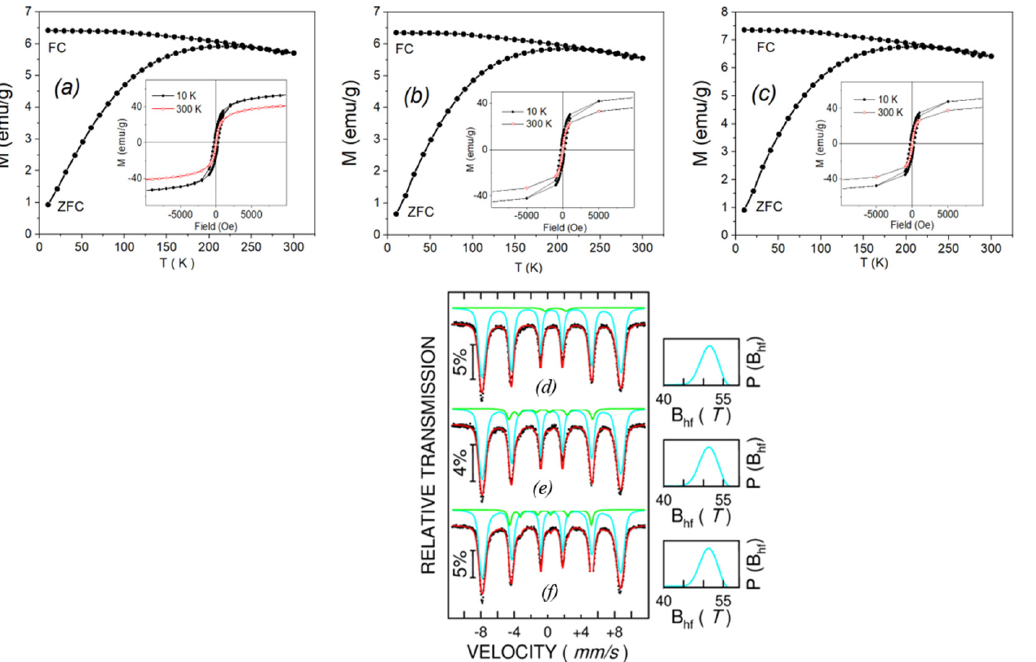
Figure 4. ZFC-FC curves in 100 Oe and hysteresis loops at 10 K (black line) and 300 K (red dashed line) for ( a ) Fe 3 O 4, ( b ) Fe 3 O 4 -L-Cys and ( c ) Fe 3 O 4 -L-Cys-Dox NPs. 57 Fe M ӧ ssbauer spectra collected at 6 K on ( d ) Fe 3 O 4 , ( e ) Fe 3 O 4 -L-Cys and ( f ) Fe 3 O 4 -L-Cys-Dox NPs. The 6 K M ӧ ssbauer spectrum of Fe 3 O 4 -L-Cys NPs was fitted, beside the broad external sextet (with most probable hyperfine magnetic field of 51.0(2) T and average IS = 0.45(2) mm/s), by an additional inner sextet with hyperfine parameters (hyperfine magnetic field of 31.0(2) T, QS = 0.9 mm/s and IS = − 0.06 mm/s) specific to Fe 2+ ions in an intermediate spin state. Its relative spectral area is of 11(1)%. This additional component may be assigned to those most active Fe positions interacting with active centers of the L-Cys molecules, leading to the formation of Fe 2+ in very distorted atomic positions. However, such positions can be found only at the NPs’ surface, namely in the magnetic dead layer, and, therefore, cannot significantly modify the magnetic moment of the nanoparticle (and its average magnetization). Finally, the 6 K M ӧ ssbauer spectrum of Fe 3 O 4 -L-Cys-Dox NPs is very similar to that of Fe 3 O 4 -L-Cys NPs (almost the same relative spectral area of the additional inner sextet), giving support for the interaction of the Dox molecule with the L-Cys molecules already bound to the Fe ions in the Fe 3 O 4 NPs. FT-IR spectroscopy was performed to identify the functional groups of Dox and L-Cys (used as a binder and capping agent in the synthesis of magnetic NPs) (Figure 5). The presence of Fe-O stretching vibration of tetrahedral sites of spinel structure, con- firmed by the two strong absorption bands around 573 and 618 cm − 1 , proves the magnetic NPs’ formation [48]. In the case of L-Cys, the characteristic 𝝊 𝒂𝒔 asymmetric (~1591 cm − 1 ) and 𝝊 𝒔 symmetric stretching (~1404 cm − 1 ) corresponding to the COO- group were iden- tified. Further, the peak at 1583 cm − 1 is attributed to the bending vibration of –NH. A weak band near 2557 cm − 1 assigned to the -SH groups of L-Cys molecules can be ob- served, and the very broad band of (–NH 2 ) and (–CH) stretching is located in the 3000– 3500 cm − 1 range. The Fe–O stretching mode of the tetrahedral sites can be identified in the band at 543 cm − 1 , and the band located at 582 cm − 1 is sharp and symmetric, whereas the Fe–OH vibration band is located at ~677 cm − 1 , which is specific for magnetite structure [29,39,49,50].